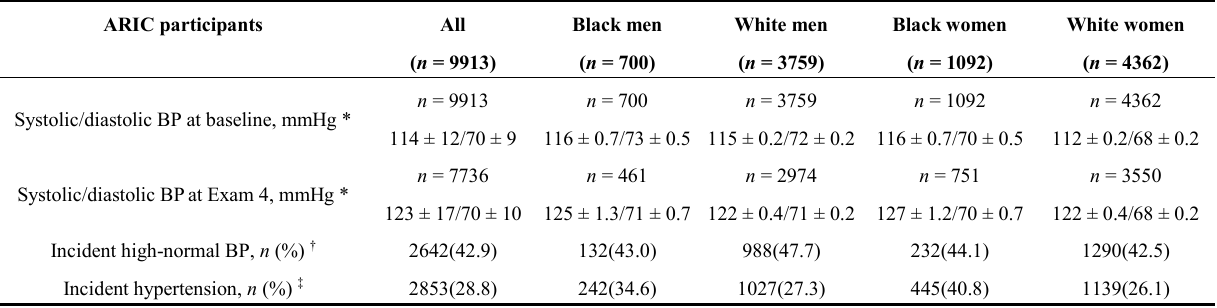
Table 1. Baseline and Exam 4 blood pressure levels and incidence of high normal blood pressure or hypertension among ARIC participants, 1987–1998.